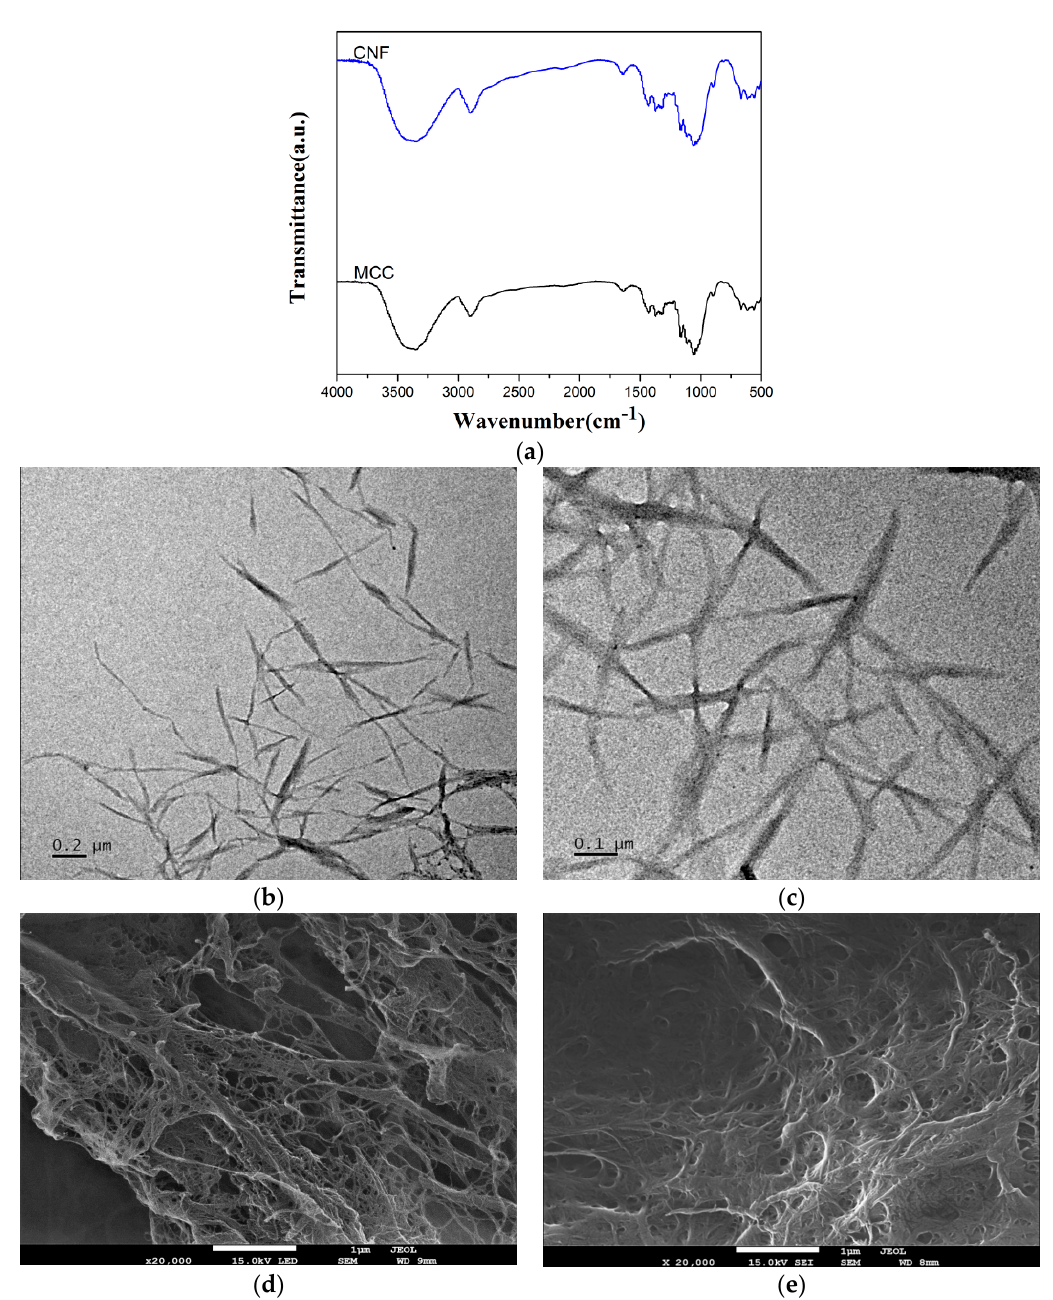
Figure 2. FTIR Spectrum of microcrystalline cellulose (MCC) and CNF. ( a ) TEM images of enzymatic hydrolysis of cellulose with high-pressure homogenization under different scales. ( b ) and ( c ) after 10 passes through the homogenizer. FE-SEM micrographs of CNF at a magnification of 20000 ( d ) after freeze-drying and ( e ) after mechanical dispersion (following freeze drying).